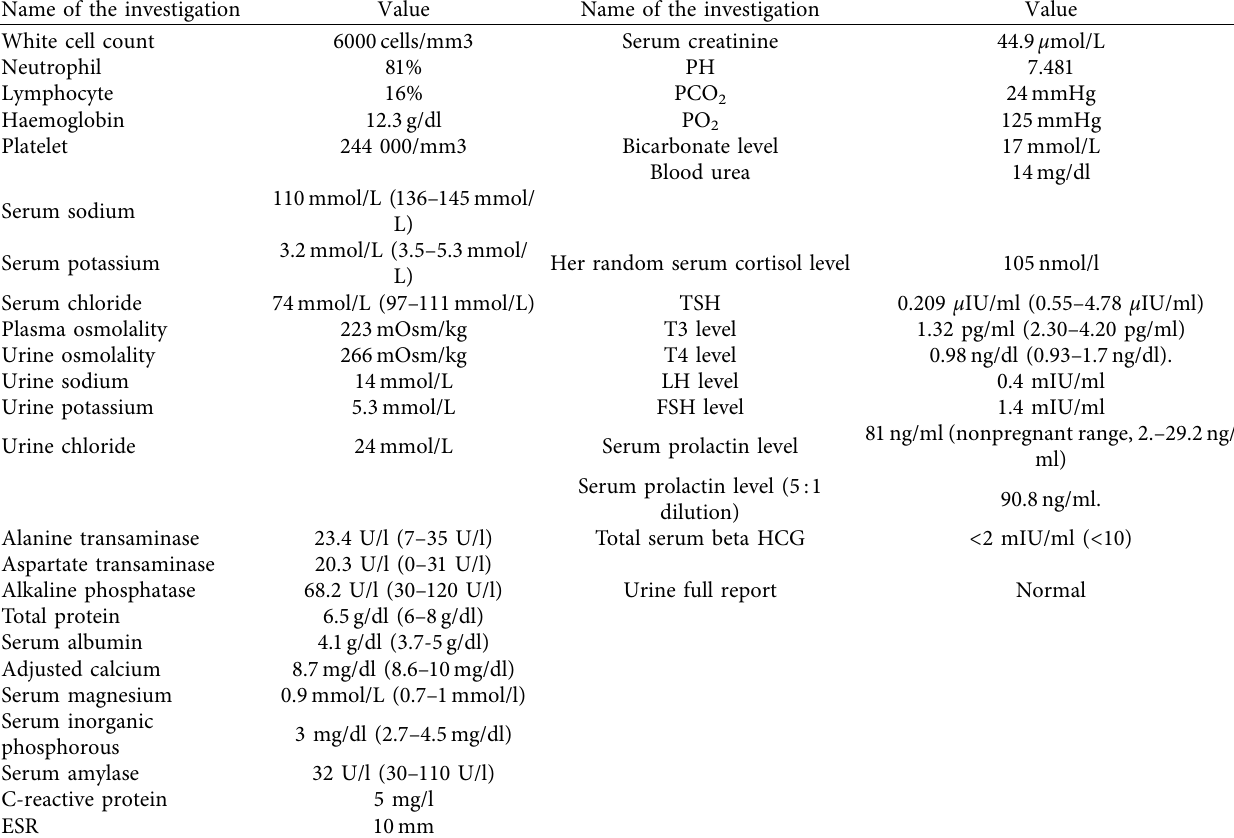
Table 1: Summary of blood and urine investigation